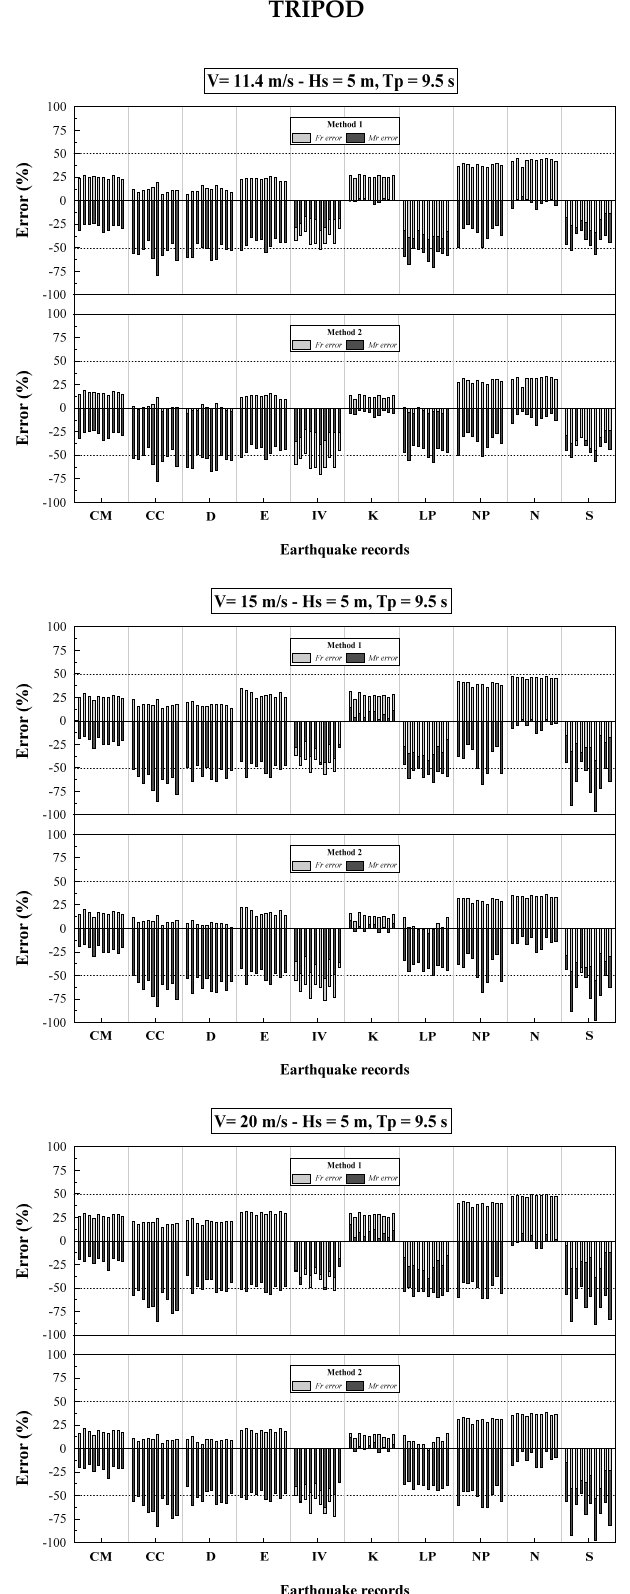
Figure 6. Tripod: Tower base errors (18)–(19) obtained by Methods 1 ‐ 2 for sea state parameters H s = 5 m, T p = 9.5 s, all wind velocities and earthquake records listed in Table 3.